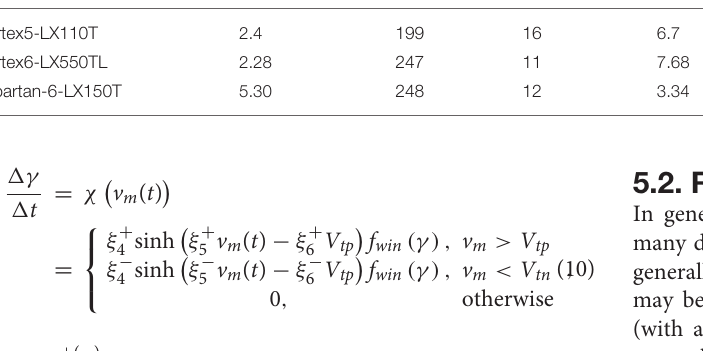
TABLE 1 | FPGA resource utilization and power consumption for hidden neuron on three FPGA.